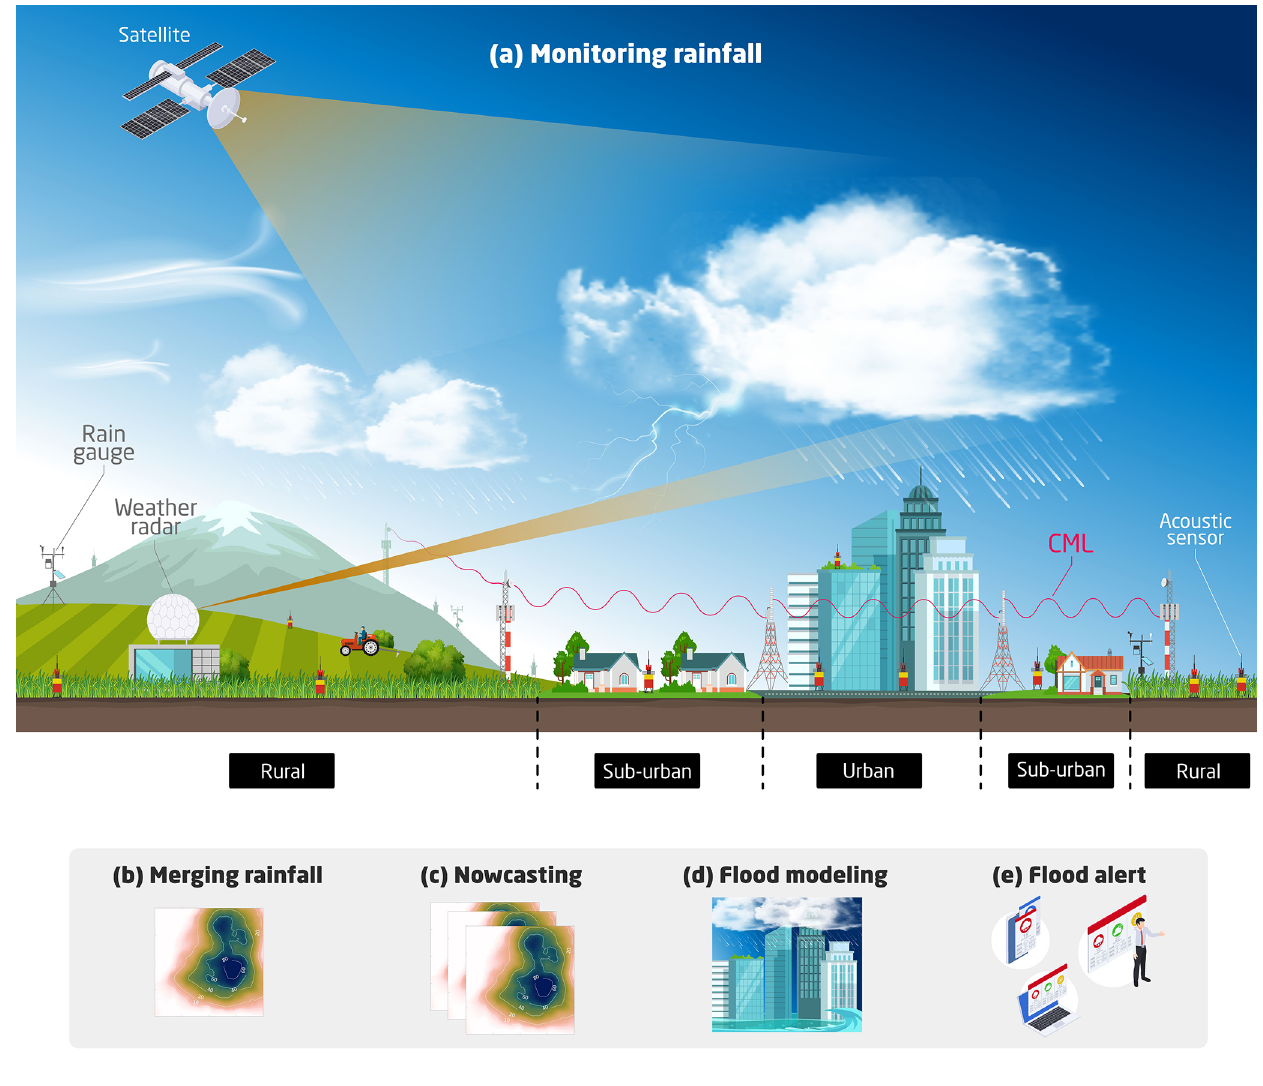
Figure 3. From rainfall monitoring to flood alerts. (a) Schematic illustration of the most common rainfall monitoring devices at different spatial and temporal scales. Real-time records from panel (a) are merged to form a representative rain field (b) , which is then used in near- real-time nowcasting (c) . The simulated nowcast rainfall from panel (c) is then fed into a hydrodynamic model to forecast urban floods in the short term (d) , and if necessary, flood alerts are sent out (e)